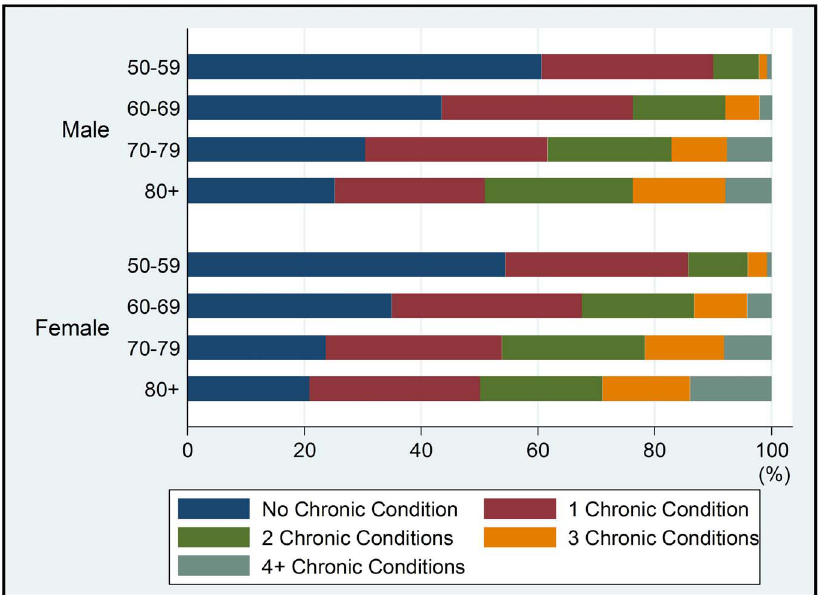
haemoglobin results for the SAGE China respondents will be published elsewhere, and could be used to compare to self-report. Stroke represents the third leading cause of death and the second leading cause of disability and dementia in the adult population over 65 worldwide [22]. Self-reported prevalence of stroke in this study was 3.1%. it is very close to the prevalence rate among